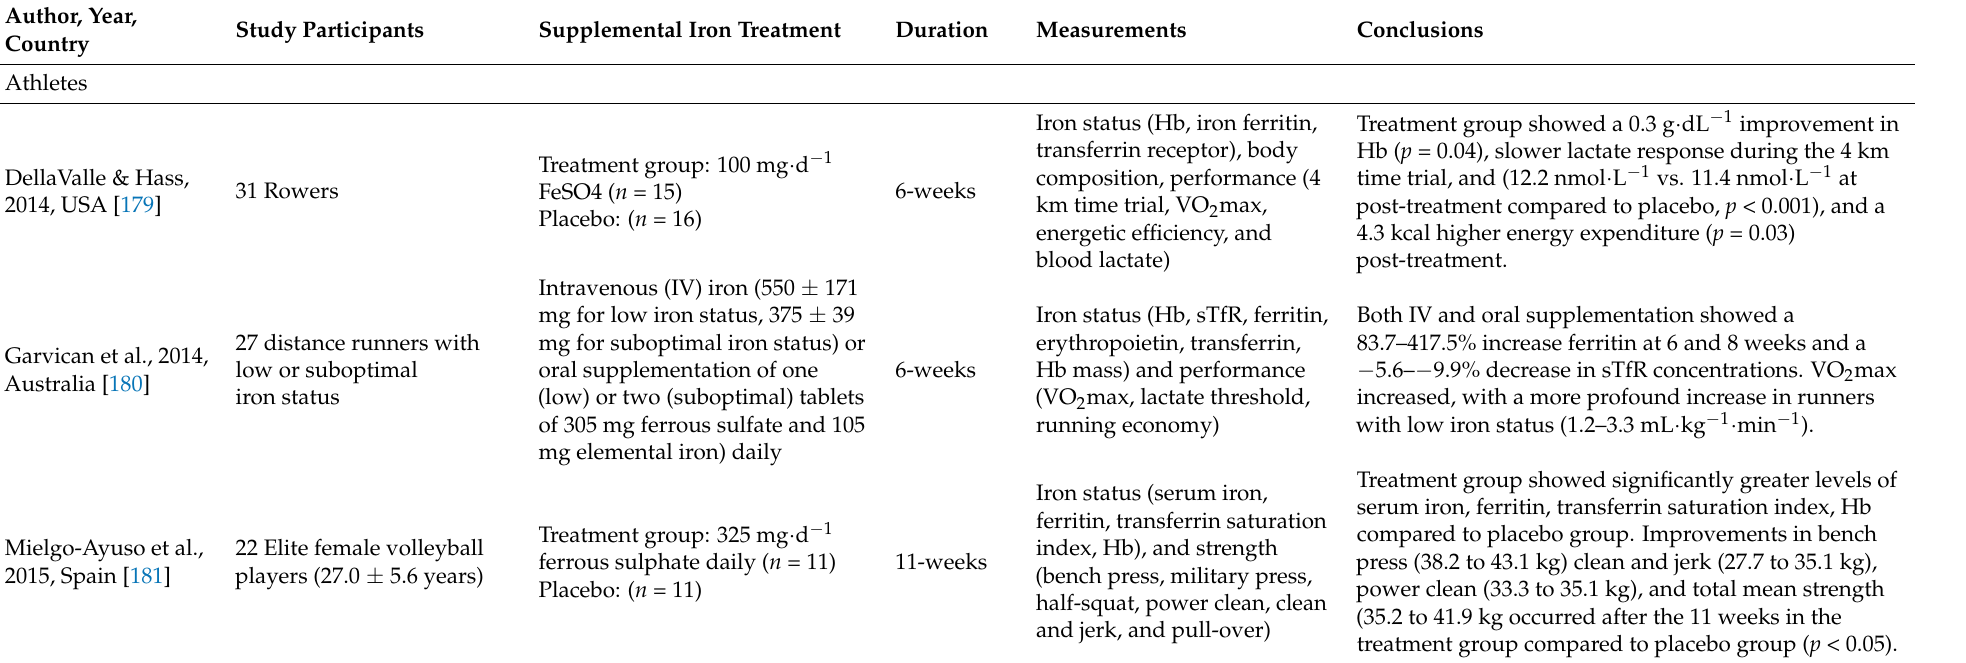
Table 4. Experimental studies examining the effects of iron supplementation on muscle